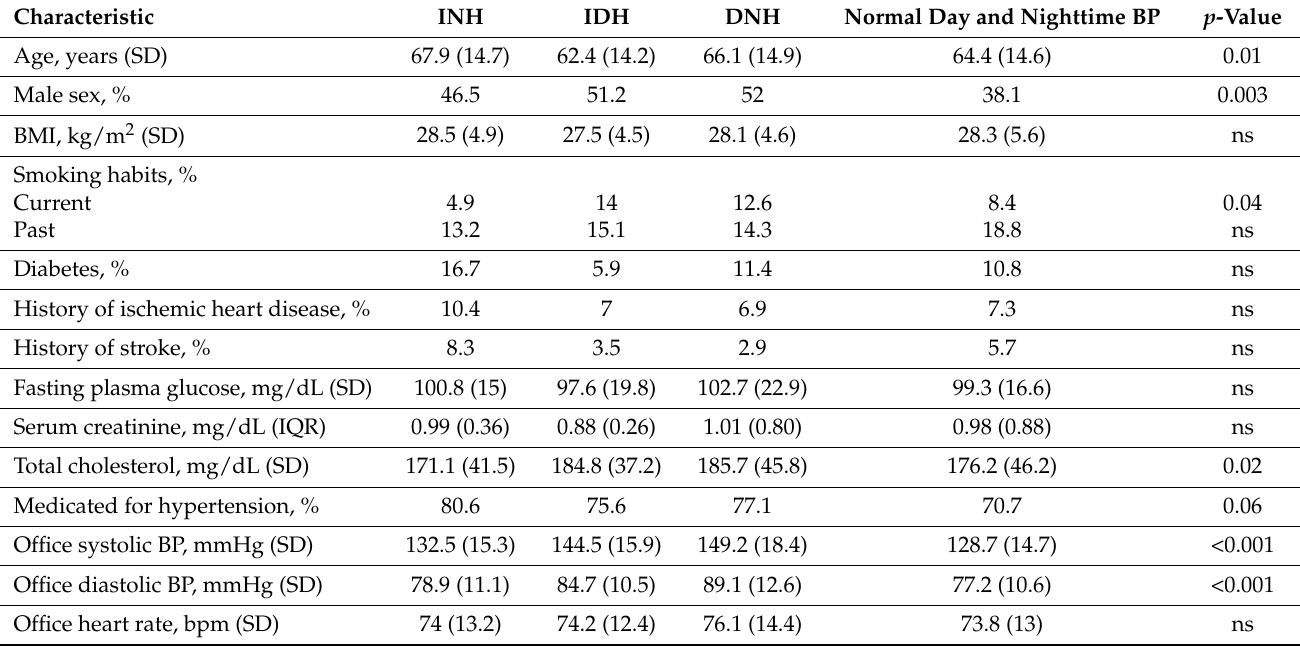
Figure 5. Nighttime diastolic blood pressure among the three blood pressure categories: isolated nocturnal hypertension, isolated diurnal hypertension, and day-night hypertension. BP, blood pressure; INH, isolated nocturnal hypertension; IDH, isolated diurnal hypertension; DNH, day-night hypertension. p < 0.001 for all three comparisons (one-way ANOVA test with Bonferroni correction). In bivariate analyses, patients with INH were significantly older, with a lower preva- lence of smoking habits, a predominance of men, a higher prevalence of diabetes, a higher ambulatory heart rate, and a tendency to be more medicated for hypertension as compared with subjects with normal day and nighttime BP. They also had a lower cholesterol level and a lower office systolic and diastolic BP as compared with subjects with isolated diurnal hypertension and day and nighttime hypertension (Table 3). Table 3. Comparison between subjects with isolated nocturnal hypertension, isolated diurnal hyper- tension, day and nighttime hypertension, and day and nighttime normal